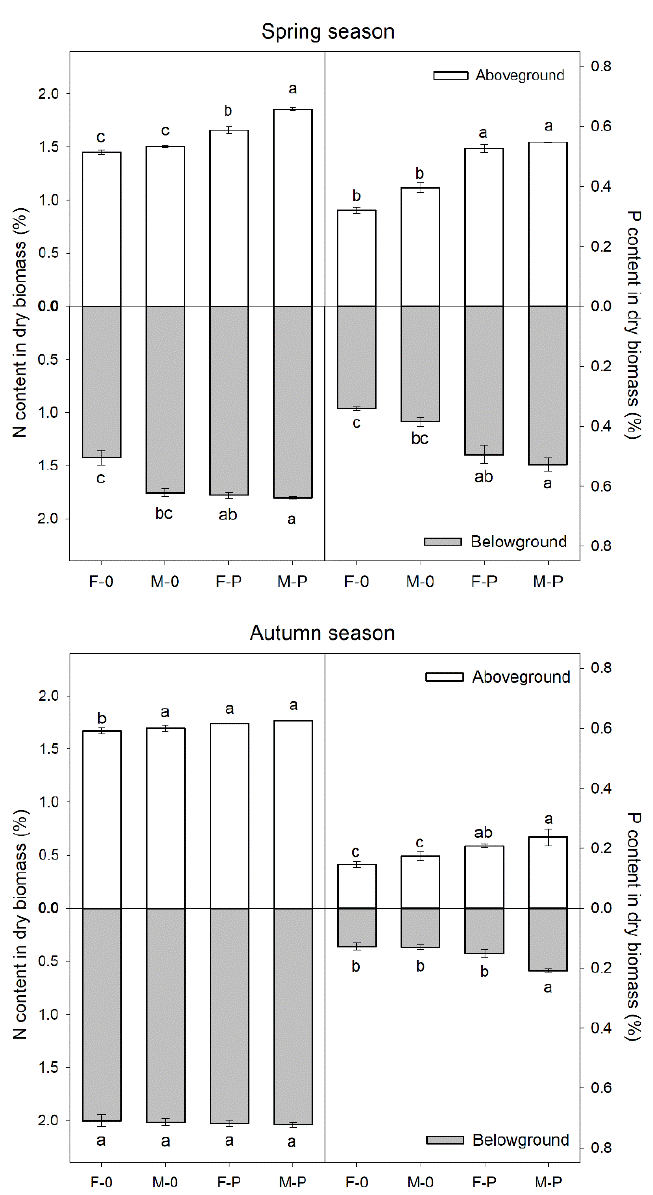
Figure 2. The N and P contents of aboveground and belowground pakchoi under water management techniques in spring and autumn seasons. F-0, M-0, F-P, and M-P were abbreviations for furrow irrigation, micro-irrigation, furrow irrigation with plastic mulch, and micro-irrigation with plastic mulch. The di ff erent lower-case letters indicate the significant di ff erence among water management techniques in each season at p < 0.05 ( n = 3).